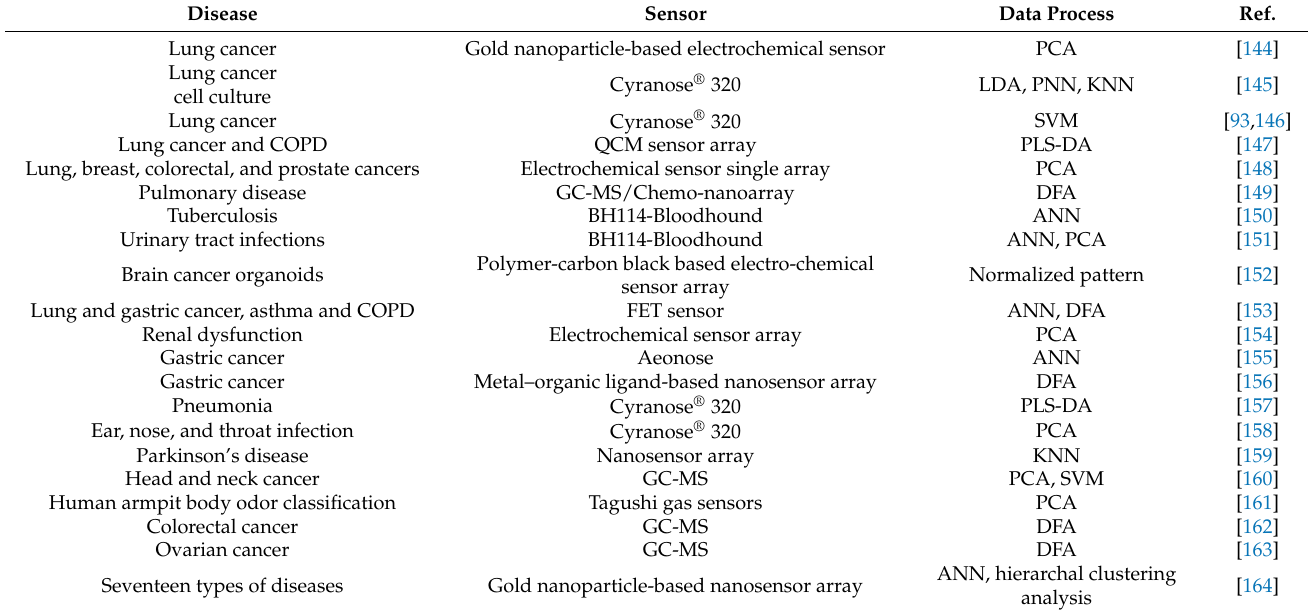
Table 3. Classification of disease groups through a data analysis algorithm using a sensor array. Disease Sensor Data Process